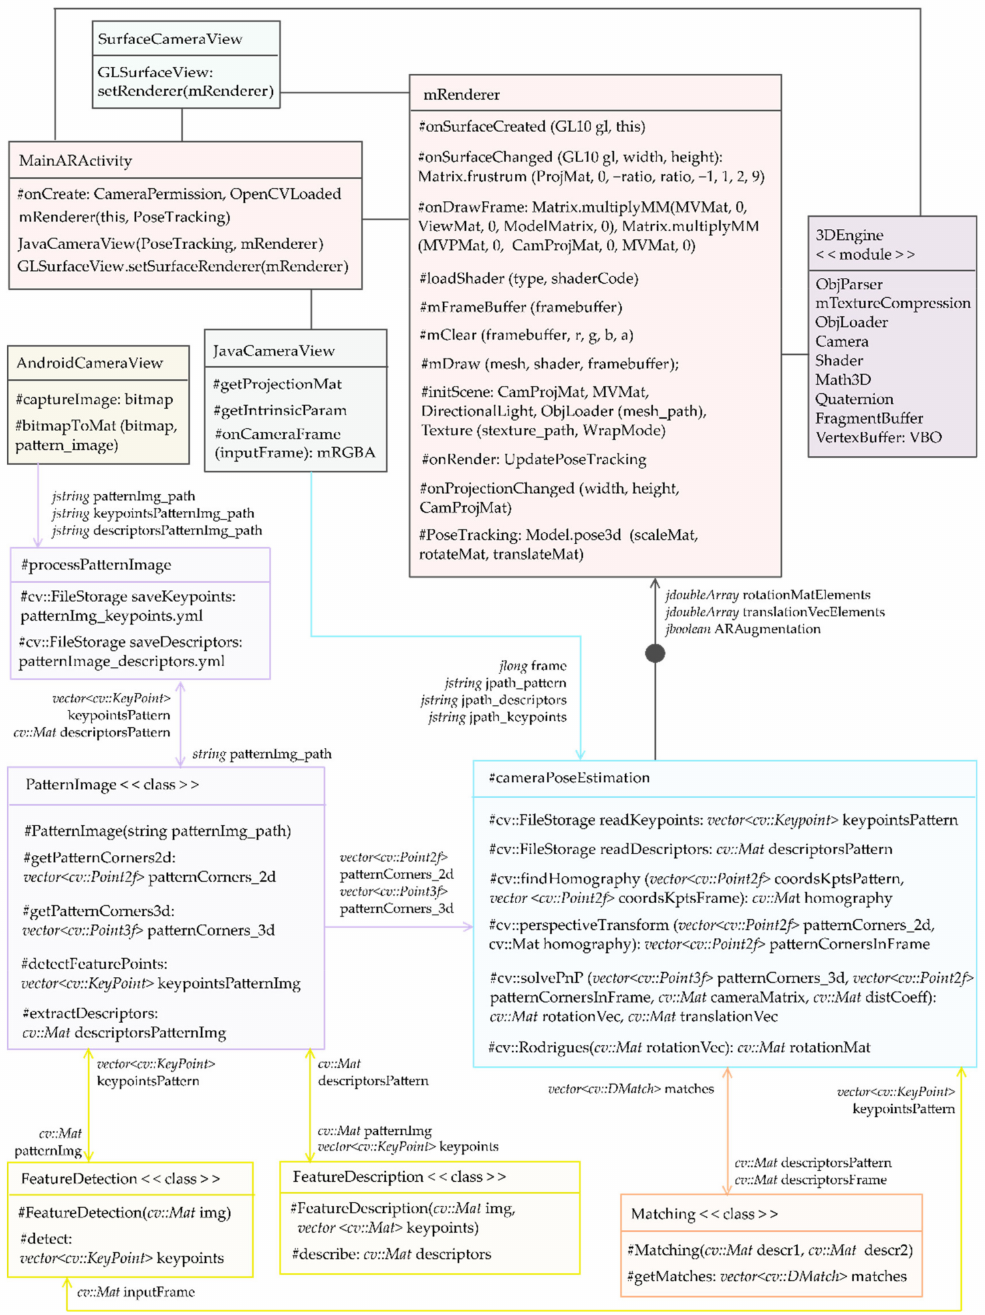
Figure 2. Activity diagram illustrating the main processes performed by the ModAR prototype. The 3D rendering thread is initialized when the instance of the 3D graphics engine is associated with the application layer. The mRenderer activity constructs a new renderer for the SurfaceCameraView . The onSurfaceCreated class enables depth testing and culling to remove non-visible back faces while onSurfaceChanged adjusts the viewport based